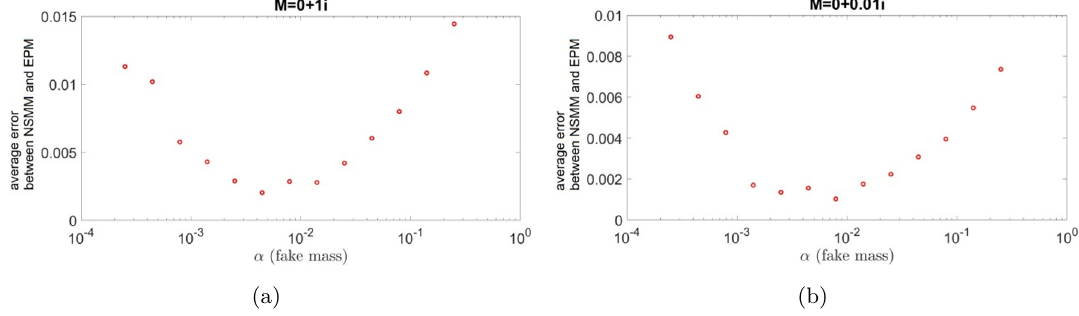
Figure 9 . Comparison between heat kernel calculations of a free scalar particle on the hyperboloid for | M | = 1 , 0 . 01 . Each point denotes a single simulation: on the horizontal axis we have the value of the fictitious mass parameter α adopted, whereas vertically we have reported an arithmetic average of distance between the data of the non-linear sigma model method and the ones of the effective potential method (assumed as a benchmark). The α -value which minimizes the error does not qualitatively depend on the curvature of the